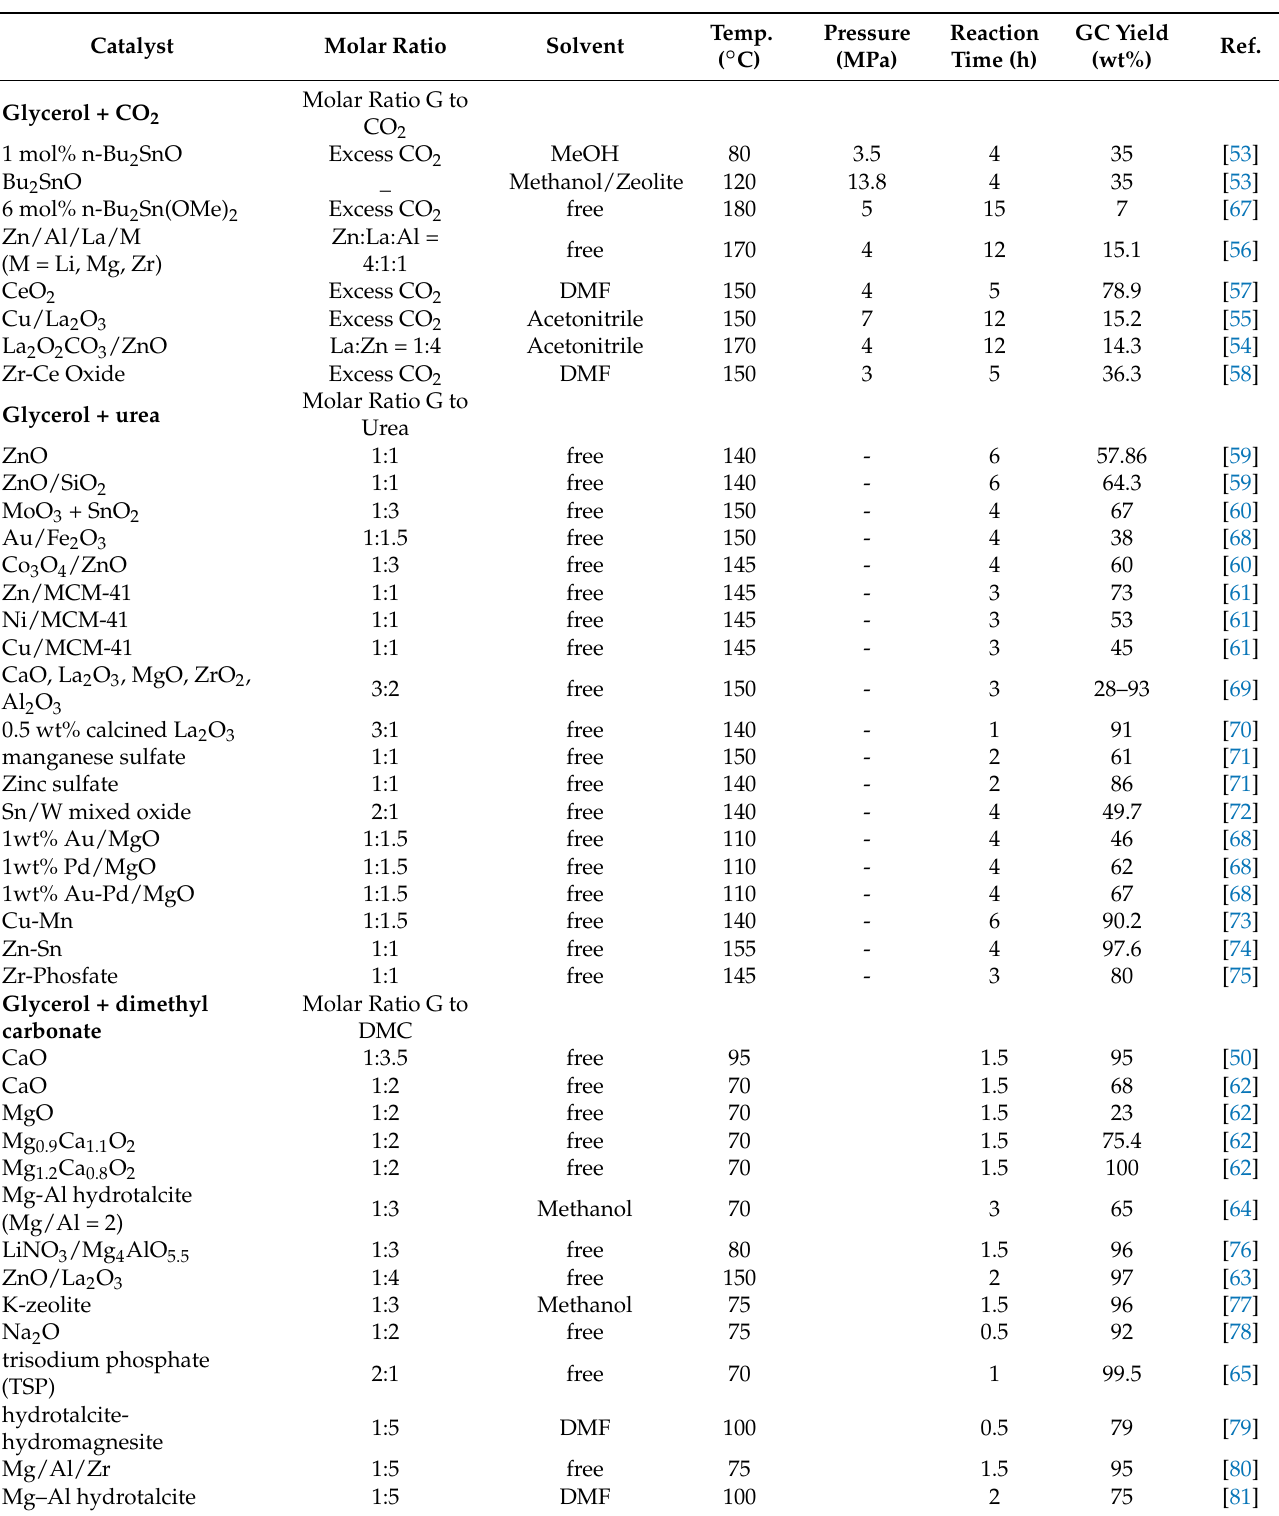
Table 1. Catalysts used for the synthesis of glycerol carbonate